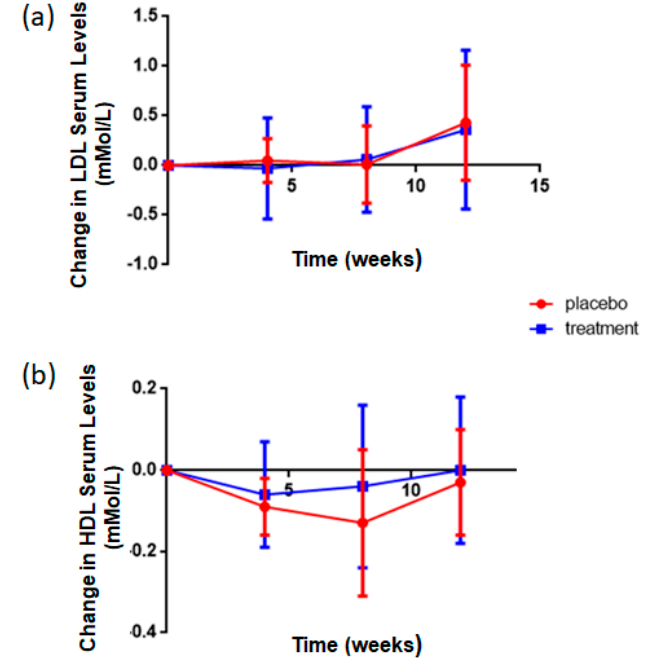
Figure 7. E ff ect of rice NPN Supplementation on LDL and HDL Serum Concentrations. ( a ) Change in the serum levels of low-density lipoprotein (LDL; mmol / l) in placebo and rice NPN (treatment). Outliers have not been removed. Each symbol represents the mean + 1 x +/ − s.d. of 10 persons in placebo and at least 27 in rice NPN group. ( b ) Change in the serum levels of high-density lipoprotein (HDL; mmol / l) in placebo and rice NPN. One outlier has been removed. Each symbol represents the mean + 1 x +/ − s.d. of 10 persons in placebo and at least 27 in rice NPN group.